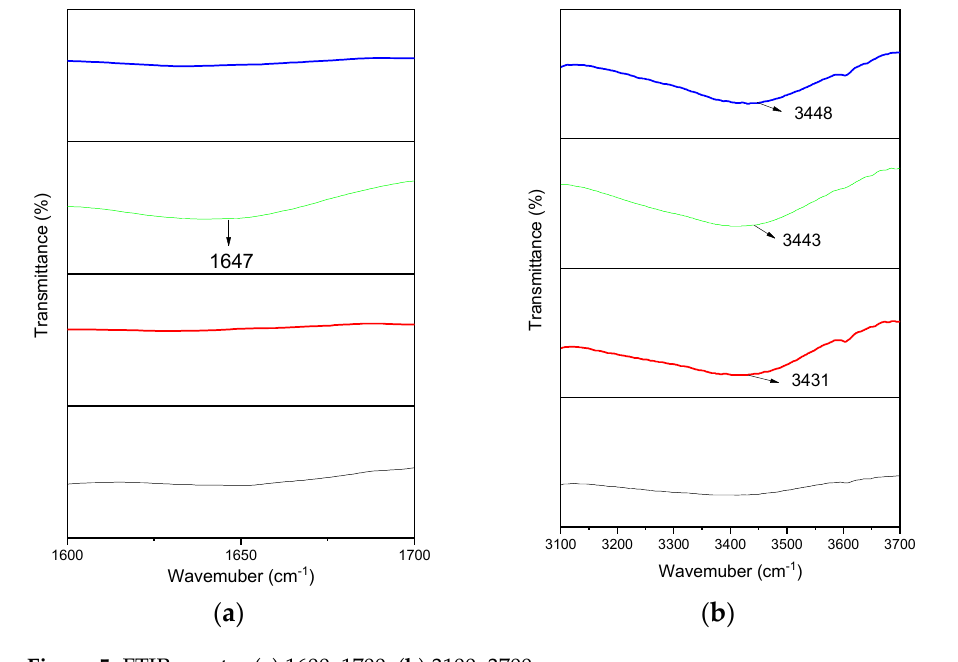
Figure 5. FTIR spectra ( a ) 1600–1700, ( b ) 3100–3700. Table 4. Spectral bands for virgin and aged